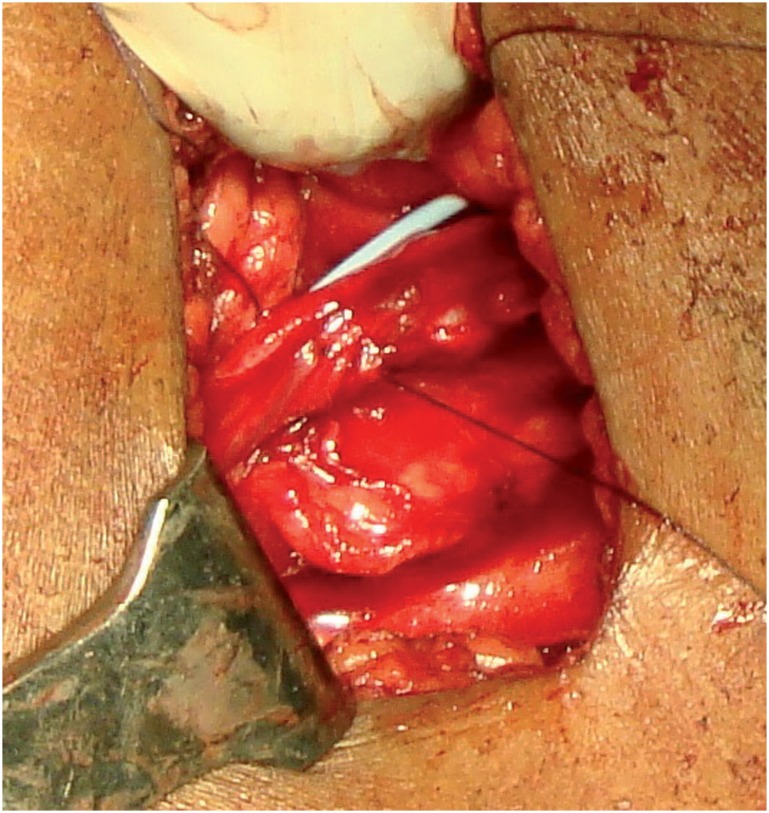
Antegrade DJ stent placement.